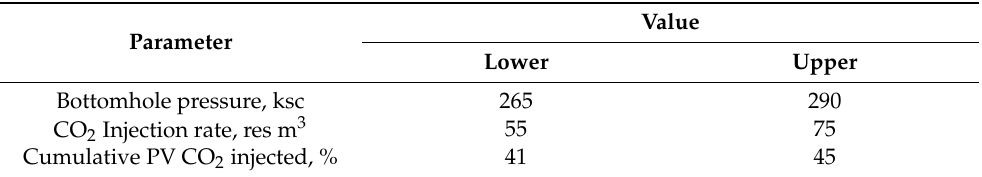
Table 5. Key Injection parameters for the CO 2 injection